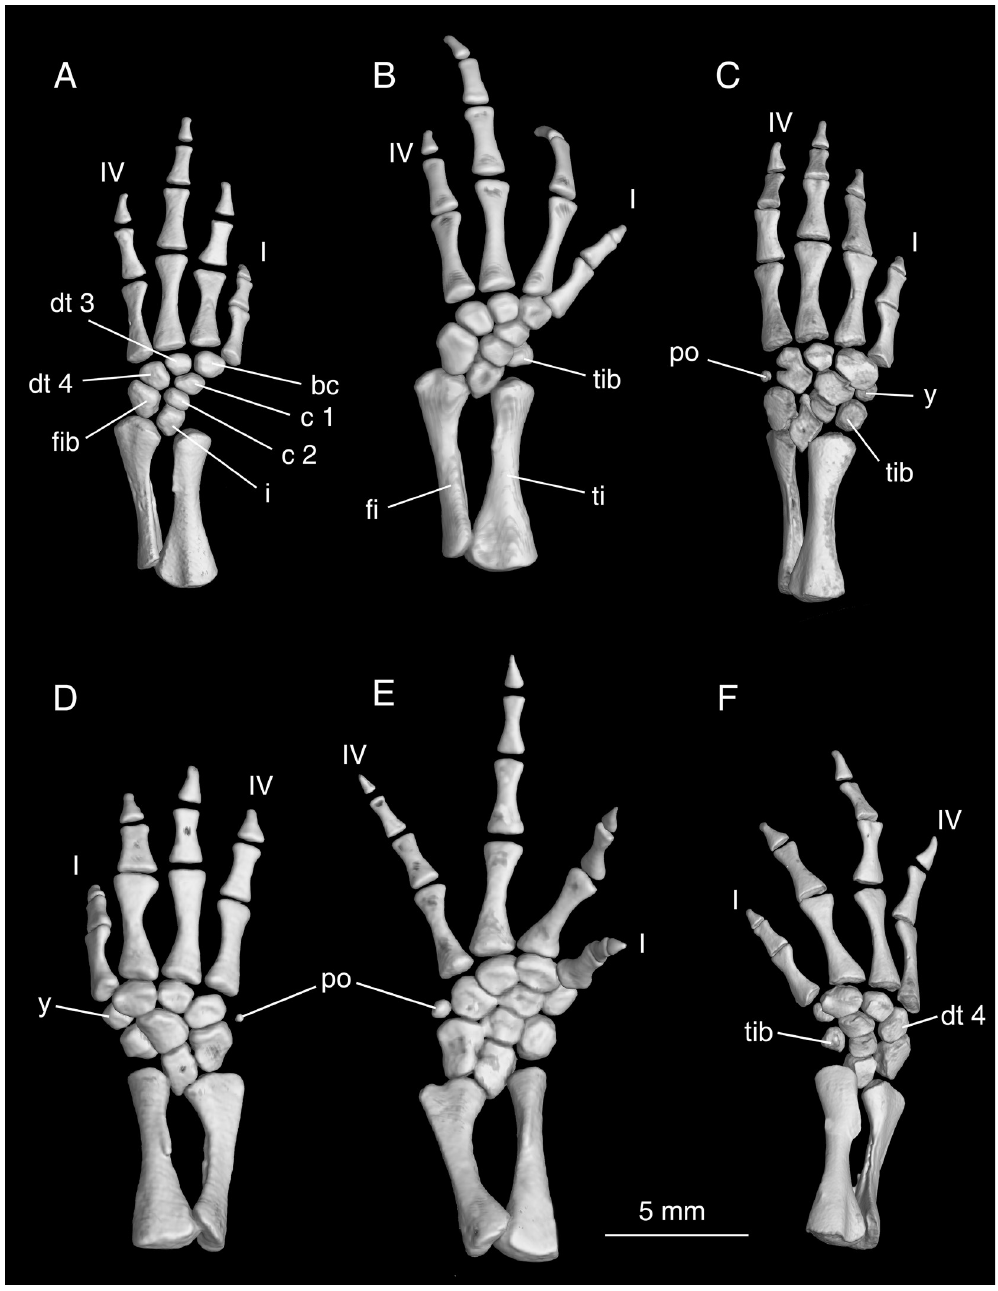
Fig 13. Micro-CT rendered reconstructions of the lower hindlimb and pes of Batrachuperus yenyuanensis . Left lower hindlimb of CIB 17309 (A), CIB 17313 (B), FMNH 49371 (C) and CIB 72597 (E); right lower hindlimb of CIB 14514 (D) and FMNH 49371 (F). Note the preaxial elements (tibiale and/or element y) are delayed in ossification in CIB 17309 and CIB17313; the two centralia are fused in CIB 14514 but remain separated from each other in all other specimens; the postminimus is ossified in FMNH 49371, CIB 14514 and CIB 72597. CIB 14514 from Maoniudui, Dechang County; CIB 17309, 17313, and FMNH 49371 from Shuangertang, Yanyuan County; CIB 72597 from Tuowu, Mianning